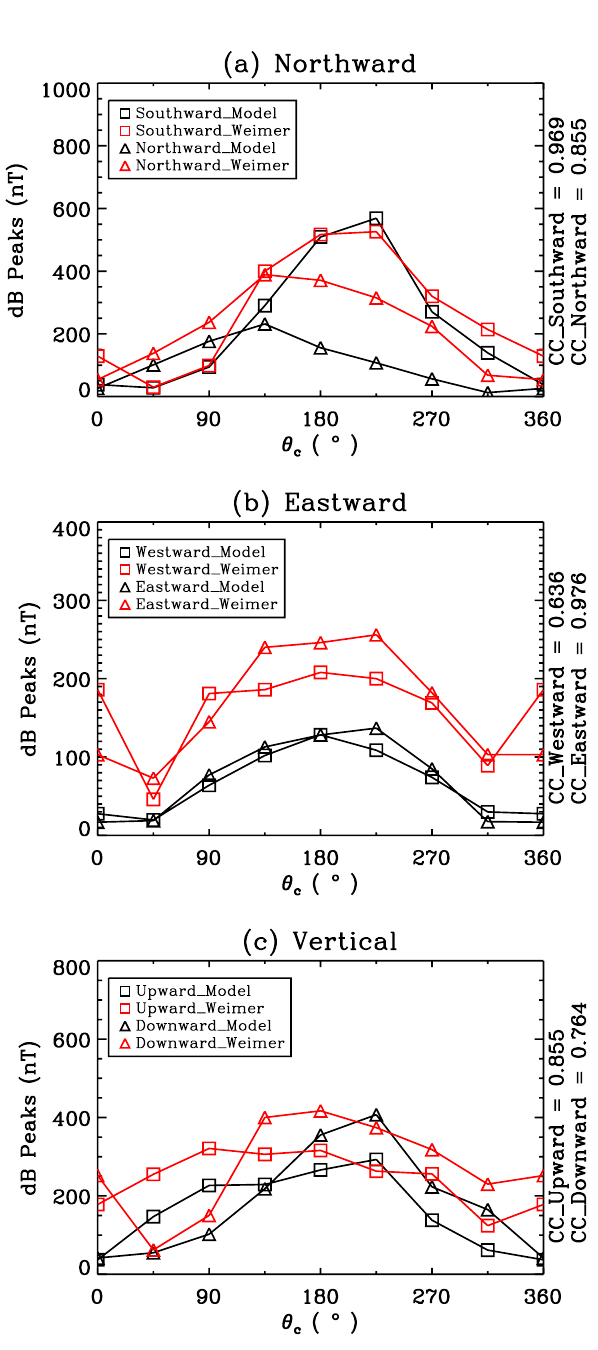
Fig. 6. Peak values of the geomagnetic perturbations as a function of the IMF clock angle θ c . From top to bottom three graphs show the (a) northward, (b) eastward, (c) vertical components. Triangle and square symbols represent respectively the most positive and neg- ative perturbation. Red symbols denote the statistical peak values from Weimer et al. (2010) and the black symbols denote the mod- eled peak values. Cross-correlation coefficients between the simula- tion and the observation are labeled on the right axis for each